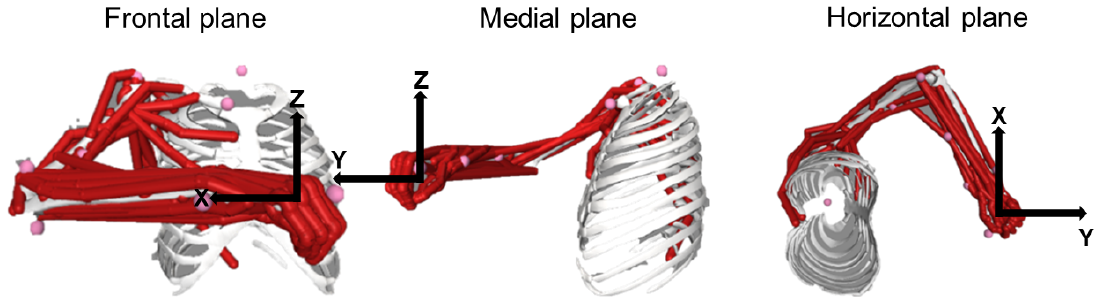
Figure 2. The posture at which the Musculoskeletal model was set to mimic the posture assumed by participants during the isometric task. Left panel: frontal plane; Middle panel: medial plane; Right panel: horizontal plane.